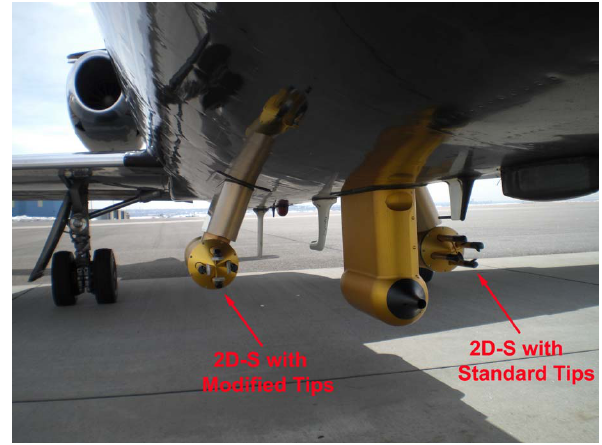
Figure 3. Photograph showing the SPEC Learjet used in the SPARTICUS project with two 2D-S probes, one with tips modified to reduce shattering, and the other with standard tips. shattering, and the other with standard tips.